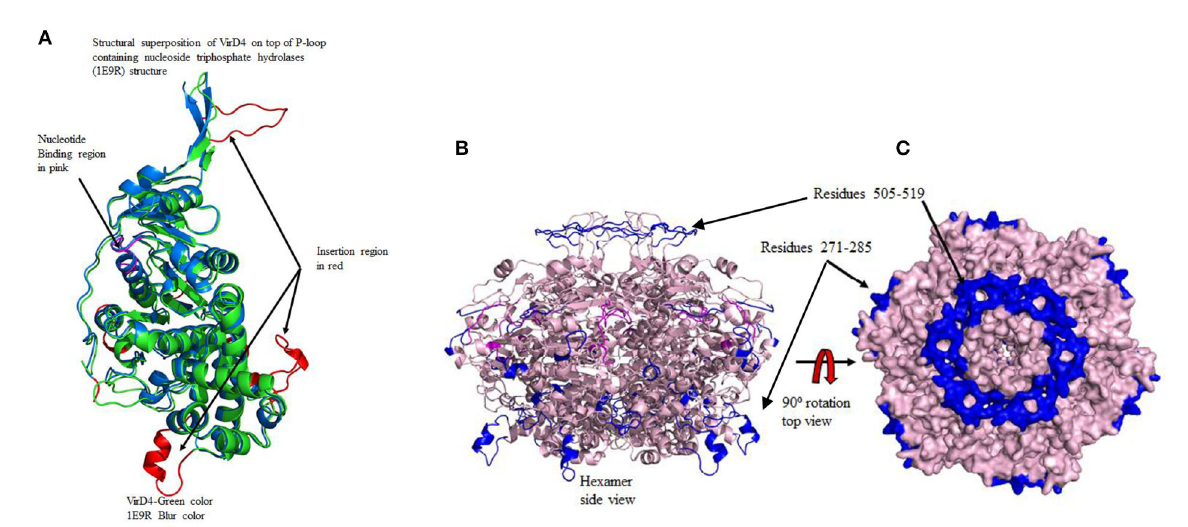
FIGURE2 (A) The structural superposition of modeled VirD4 structure on top of 1E9R template structure. This diagram also shows the insertion regions and nucleotide binding regions in different colors. Color code: green VirD4 and cyan 1E9R template structure. The two long insertion regions are labeled as Regions I (residues 271-295) and II (residues 505-519). (B) The left side of the diagram shows the formation of the hexamer. The nucleotide-binding regions are located at the dimer interface shown in pink. Two long insertion regions are shown in blue, one occupies the top of the hexamer and the other is at the bottom. The transmembrane binding region forms a circular disc to insert into the membrane. (C) The right surface diagram shows the top view. In the hexameric form, the opening of the tunnel is much wider near the transmembrane